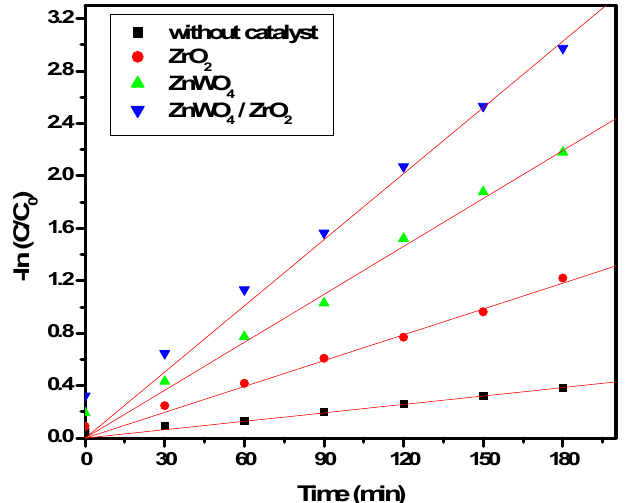
Fig.11. Kinetics regime on the photodegradation of MO in the presence of ZrO